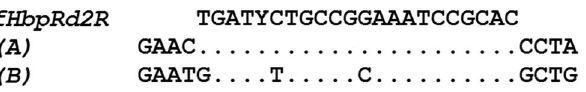
Figure 2. Conservation of the fHbpRd2R primer binding site. Single dots denote bases matching that of the PCR primer (Top sequence, 3 9 –5 9 direction). Sequence A is representative of 438/443 (98.8%) meningococcal isolates aligned (Table S2). Sequence B features the fHbpRd2R primer site mismatch. This was found in two isolates within the MGL (0.22%) and 25% of N. lactamica sequences aligned.